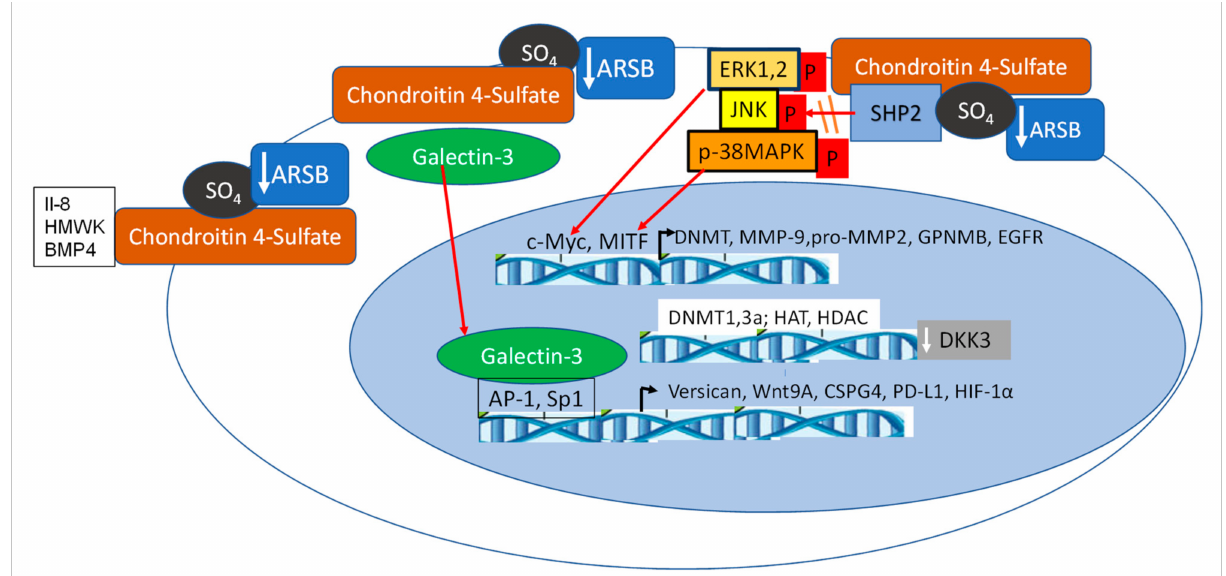
Figure 5. Overall schematic of transcriptional effects following decline in ARSB. Decline in ARSB leads to increase in chondroitin 4-sulfation, due to failure to remove the sulfate group at the non- reducing end and inhibition of degradation, as occurs in the inherited disorder MPS VI. Increased binding to C4S occurs for several vital molecules, including IL-8 [29] and BMP-4 [30]. Sequestration of IL-8 in the cell membrane can lead to increased neutrophil chemotaxis and contribute to impaired mucociliary clearance. BMP4 retention with C4S can alter Wnt-BMP interactions and reduce the Smad- mediated expression of CHST11 [30], thereby impairing production of new C4S. Galectin-3 binds less to more highly sulfated C4S, leading to availability for binding with the insulin receptor, and thereby contributing to insulin resistance [80–82]. In addition, galectin-3 acts as a co-transcriptional activator, combining with AP-1 and Sp1 for enhanced transcription of versican [37], CSGP4 [33], HIF-1 α [35], Wnt9A [32], and PD-L1 [85]. In contrast, SHP2 binds more with C4S when ARSB